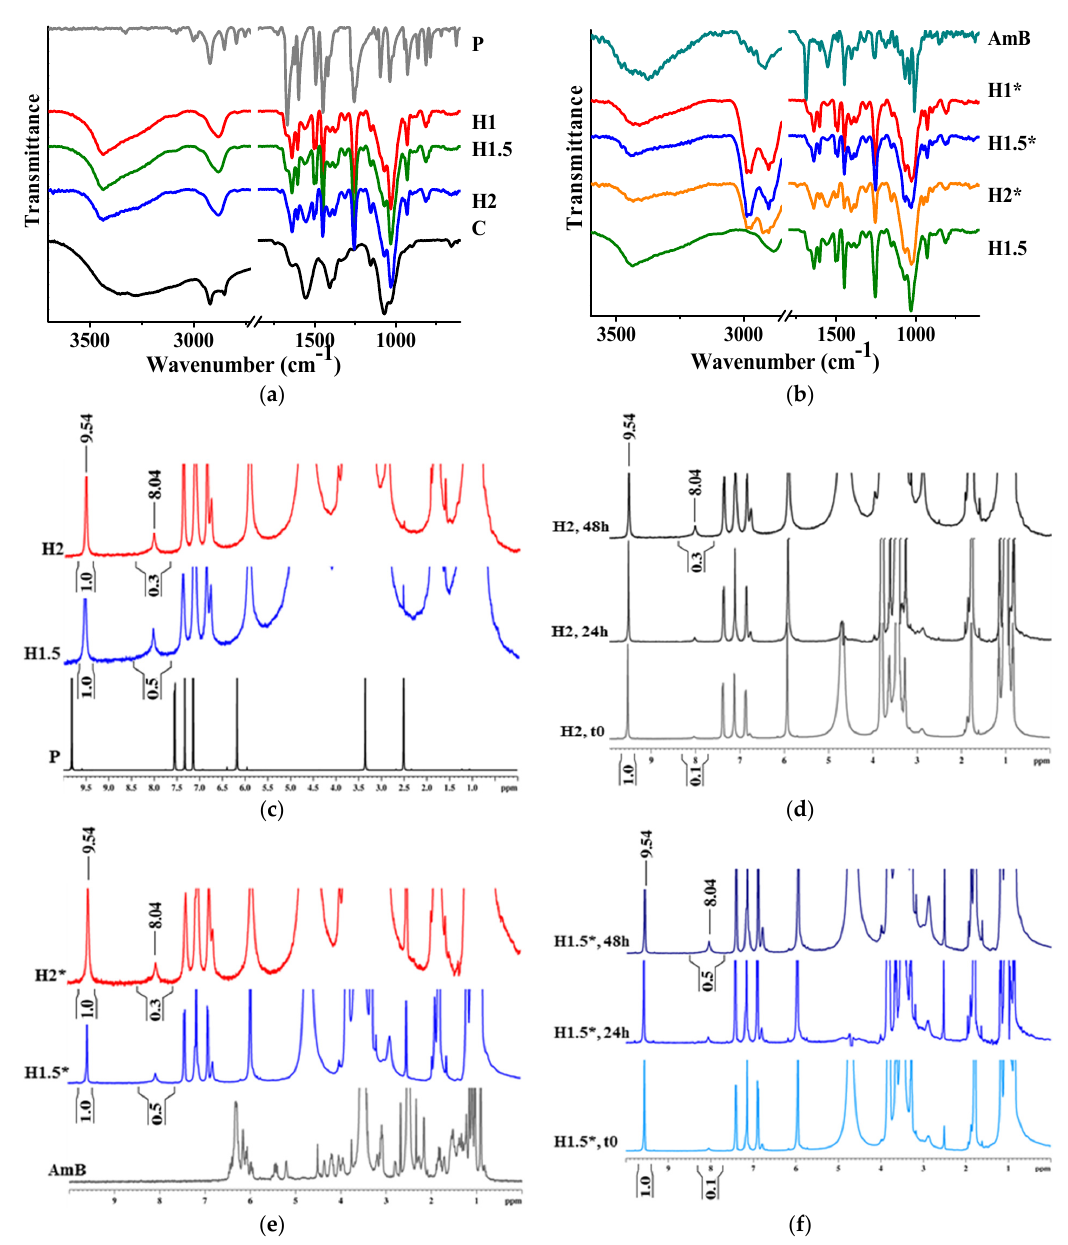
Figure 1. ( a , b ) FTIR & ( c – f ) NMR spectra of representative hydrogels and